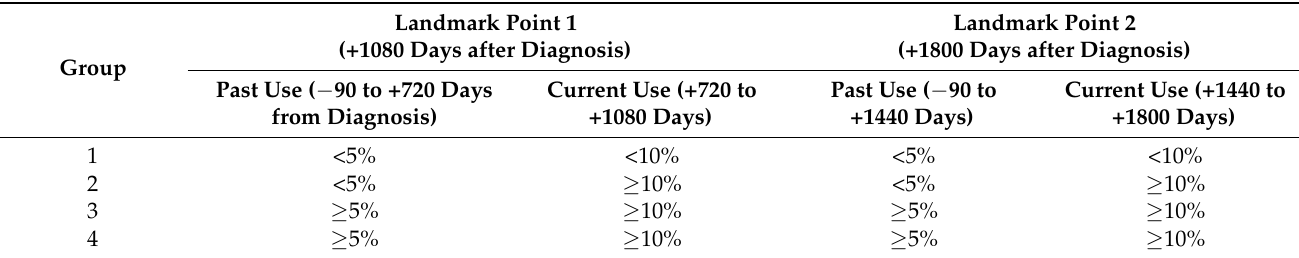
Figure 1. The definition of landmark time point. Table 1. The details of subgroup in landmark analysis of medical procession ratio.